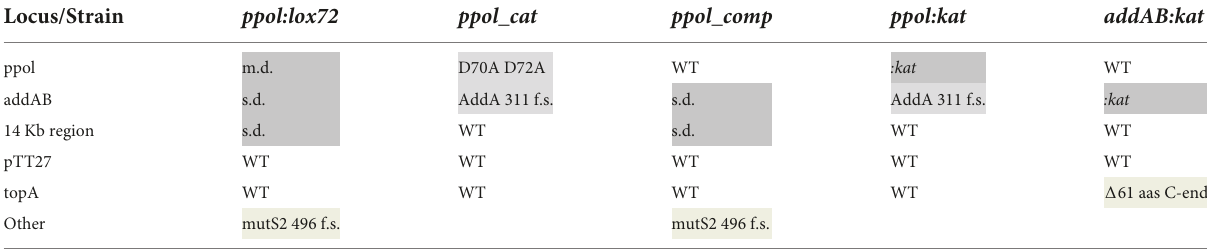
TABLE 1 Comparative table of genomic changes determined by sequencing of mutant strains.